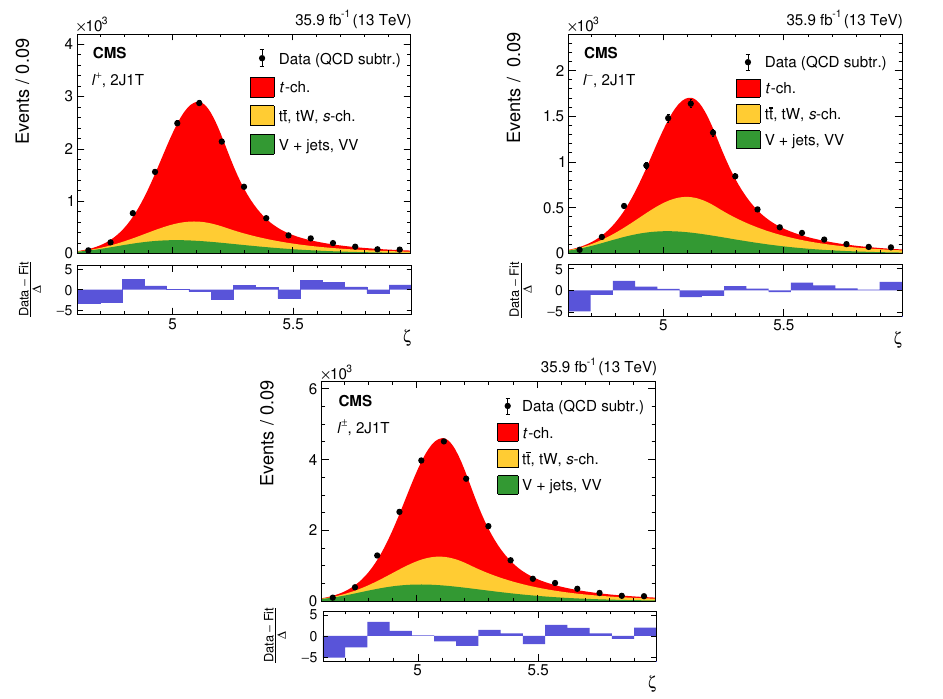
Figure 7 . Projections of fit results onto the ζ = ln( m / 1 GeV ) distributions for the l + (upper t left), l − (upper right), and l ± (lower row) final states for signal and background processes compared to data in the 2J1T category with the optimized BDT selection applied. The lower panels show the pulls that are determined using the bin contents of the data distributions (after QCD subtraction) and the F ( ζ ) values evaluated at the center of the bins. The fitted ζ distributions for each final state are combined in these plots for a comparison with data for the three different cases based on the lepton